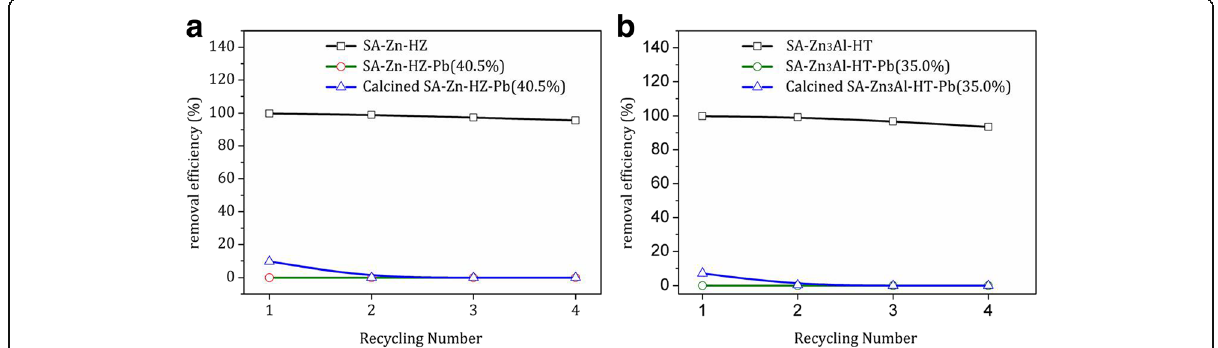
Fig. 9 Recycling for the removal of Pb(II) by a pristine SA-Zn-HZ, saturated SA-Zn-HZ (SA-Zn-HZ-Pb (40.5%)), and saturated SA-Zn-HZ after calcination; b pristine SA-Zn